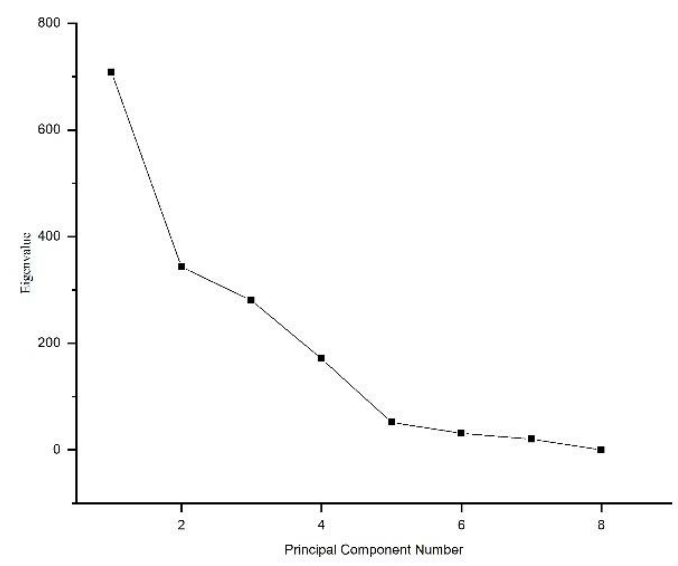
Figure 3. Scree plot for principal components (PCs).